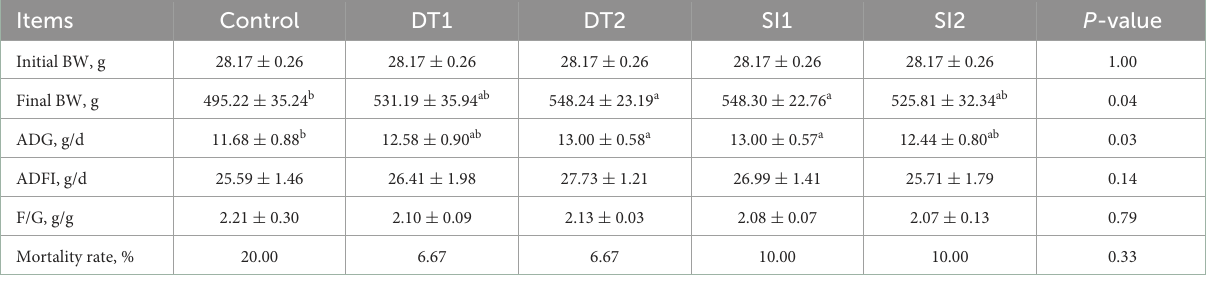
TABLE 3 Effects of dietary supplementation with dandelion tannins or soybean isoflavones on the growth performance of Wenchang chickens. Items